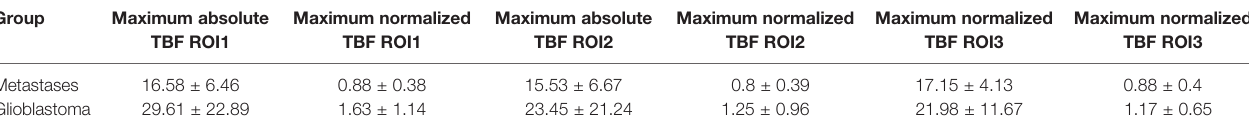
TBF, tumor blood fl ow; ROI, region of interest.